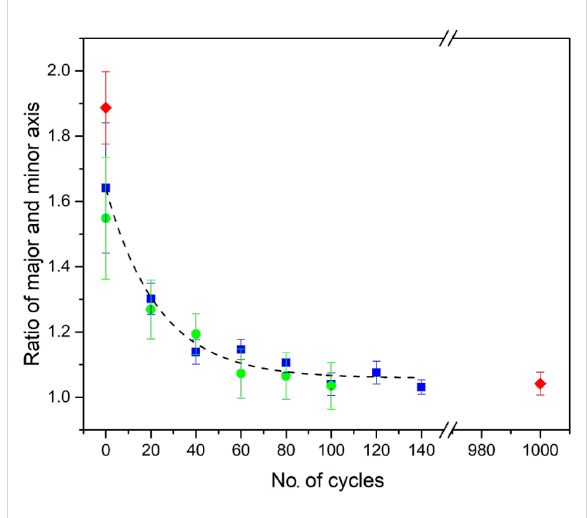
Figure 5: Ratio of major to minor axis of the elliptical fit showing the convergence of the tip apex structure to a circularly symmetric shape. Three independent runs are shown by blue, green and red symbols. The two points shown as red diamonds represent initial and final images of an adatom for 1000 mechanical annealing cycles. The black dashed curve is a guide to the eye showing an exponentially smooth transition to a circularly symmetric state.